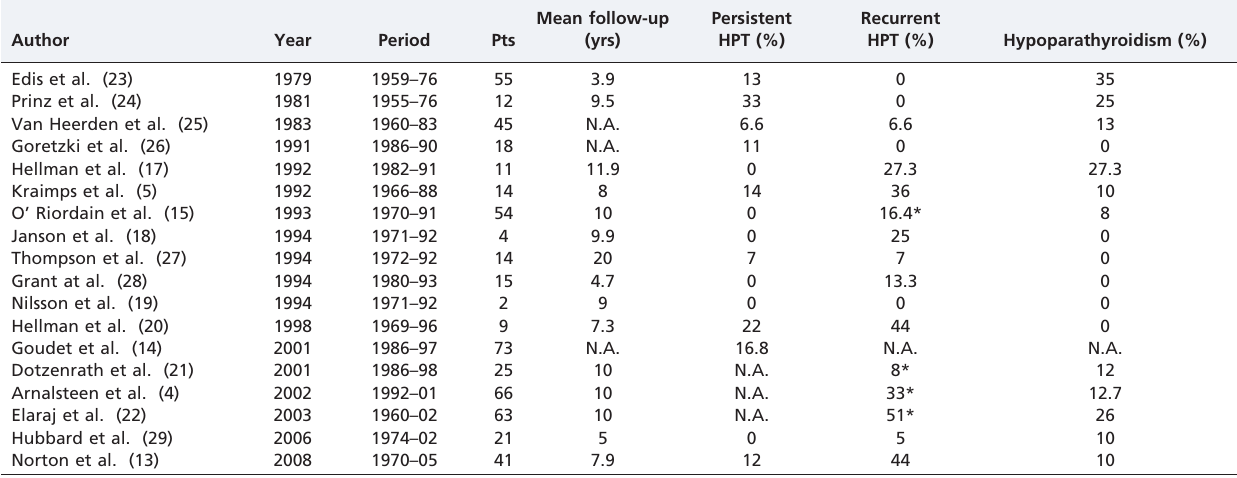
Table 1 - Results after subtotal parathyroidectomy (SPTX) in multiple endocrine neoplasia type 1 (MEN1)- hyperparathyroidism